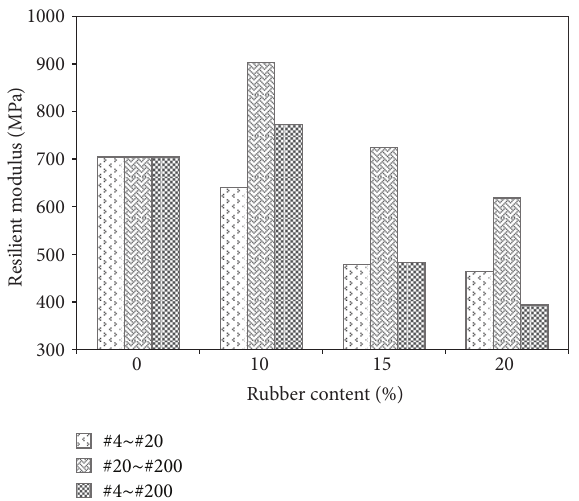
Figure 10: Effect of crumb rubber content on resilient modulus.